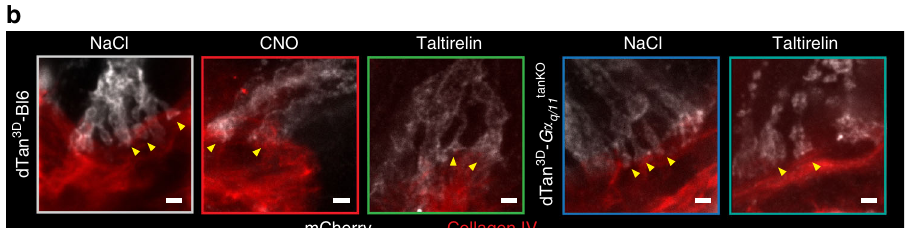
fl / fl :: G α − / − (dTan 3D - G α tanKO ) mice (2 × 10 10 genomic q 11 q/11